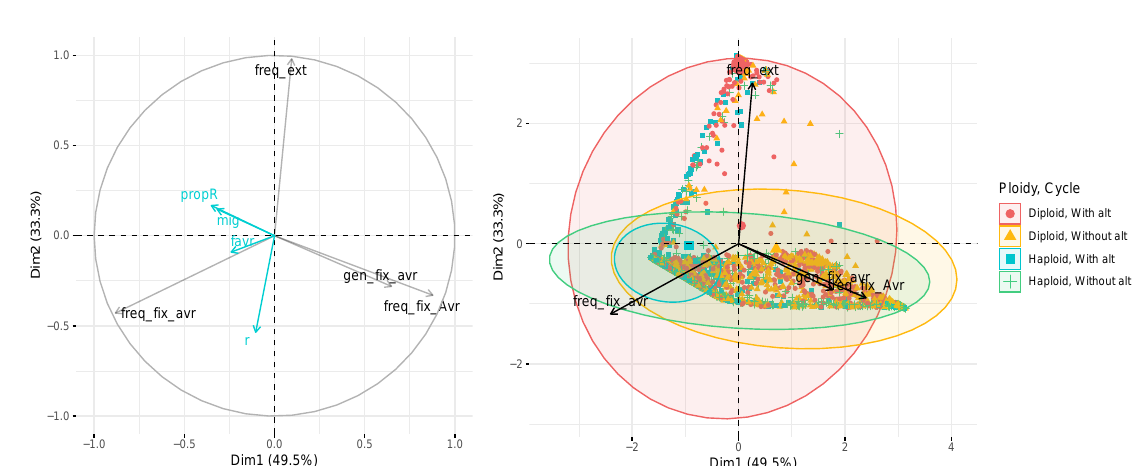
Figure 2 – Principal component analysis on four output variables: freq _ ext , freq _ fix _ Avr , freq _ fix _ avr , and gen _ fix _ avr . Two results are displayed: (a) the correlation circle on four output variables. The quantitative parameters f avr , mig , r , and propR are represented in- formatively in blue on the correlation circle and do not contribute to the variability; (b) the individual representation of simulations which represents the influence of the pathogen ploidy and life cycle. Each point represents a different combination of parameters with 100 replicates. Ellipses correspond to the 95% multivariate distribution.